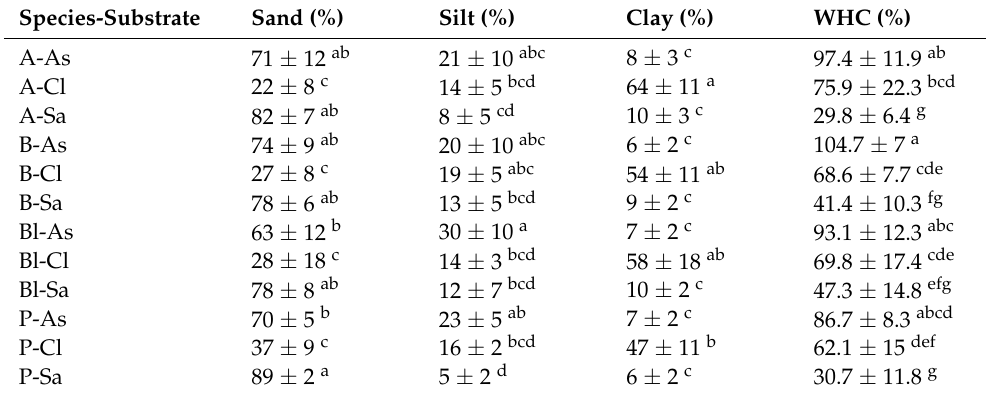
Table 2. Texture and water holding capacity (WHC) in studied technosols under different tree species.